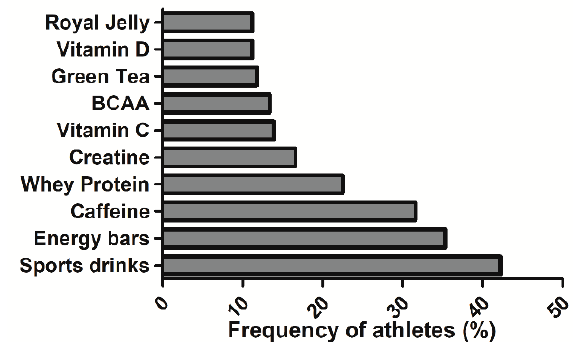
Figure 4. Type of sports supplements most commonly used in handball players. Frequency refers to the percentage of players that used each type of sport supplement with respect to the number of participants who reported use of sports supplements. The sum of all percentages is > 100% because there were players that used more than one sport supplement. BCAA: Branched Chain Amino Acids.